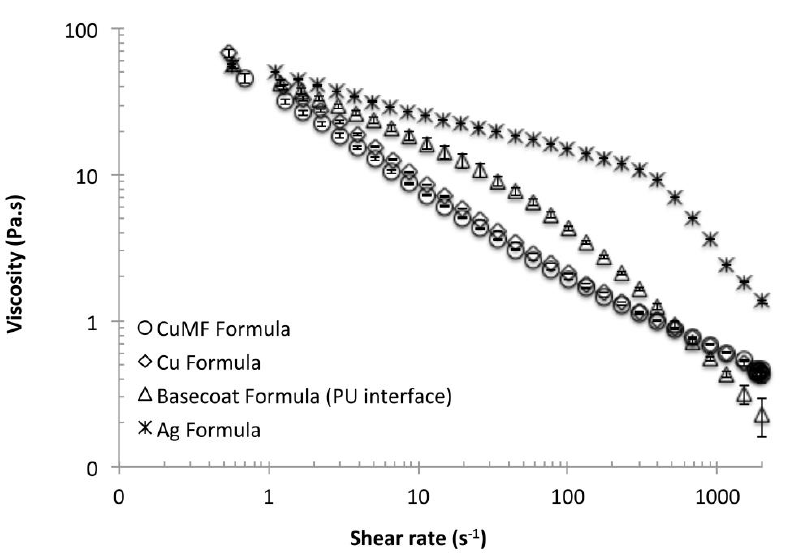
Figure 3. Viscosity versus shear rate for the three conductive formulations and the formula used at the interface. Materials 2019 , 12 , x FOR PEER REVIEW the interface.